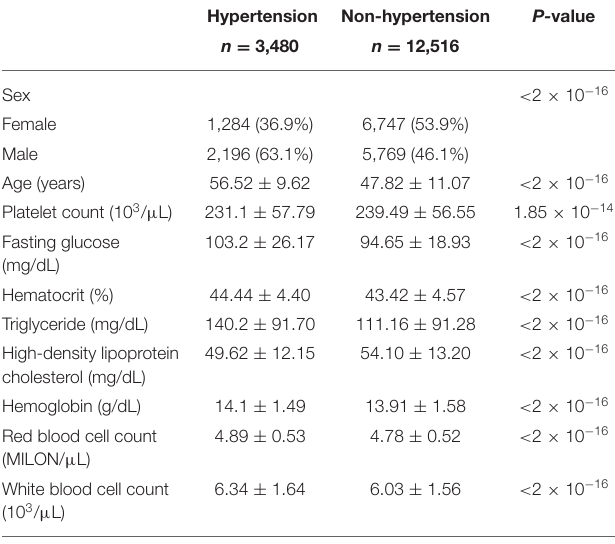
TABLE 1 | Characteristics of study participants from the Taiwan Biobank